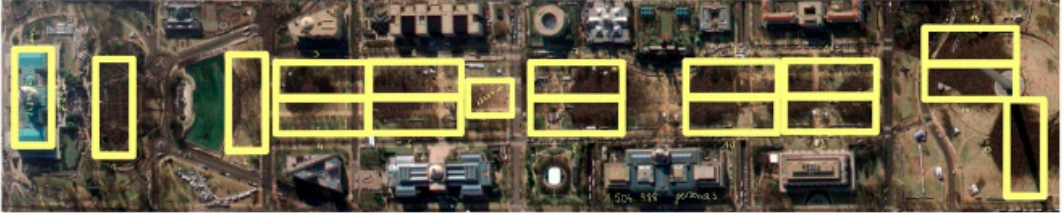
Figure A2. Translation into English of the written production for the task “the President’s supporters” analyzed above (source: prepared by the authors).